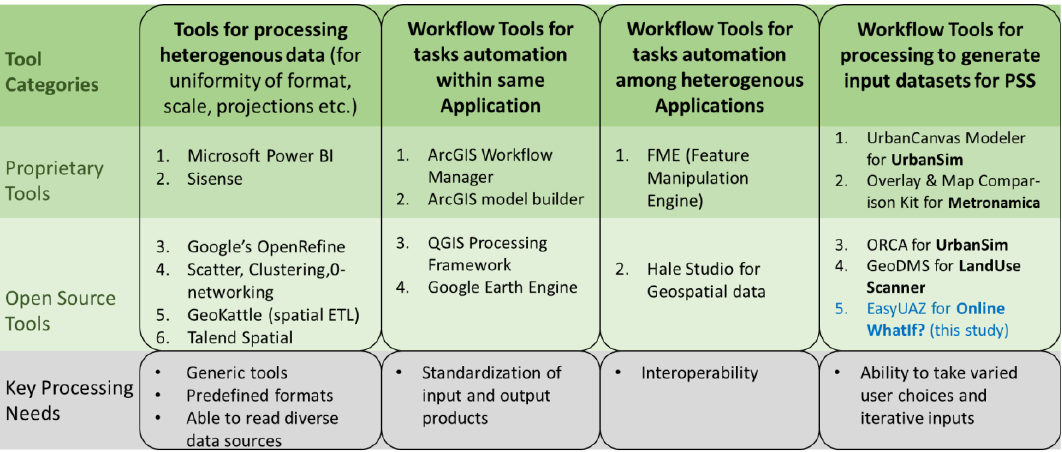
Figure 2. The categorisation of pre-processing and workflow tools.